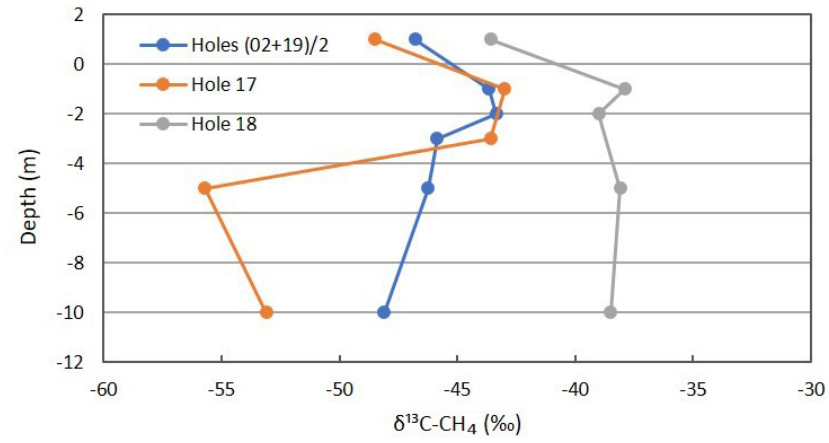
Figure 10. δ 13 C profile for CH 4 in combined background locations and Locations 17 and 18 on Fault Zone 2. See Figure 5 for the locations.